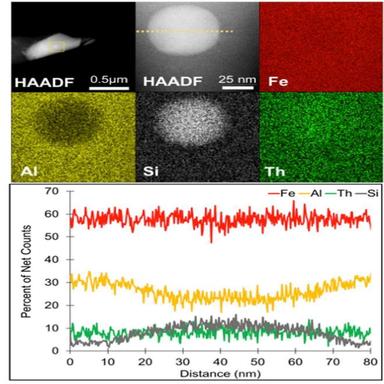
Image (HAADF) and elemental X-ray maps of a second particle with a Si-rich, Al-depleted inclusion within the AlFeThSi matrix (top) and EDS line scan across the Si-rich inclusion (bottom).